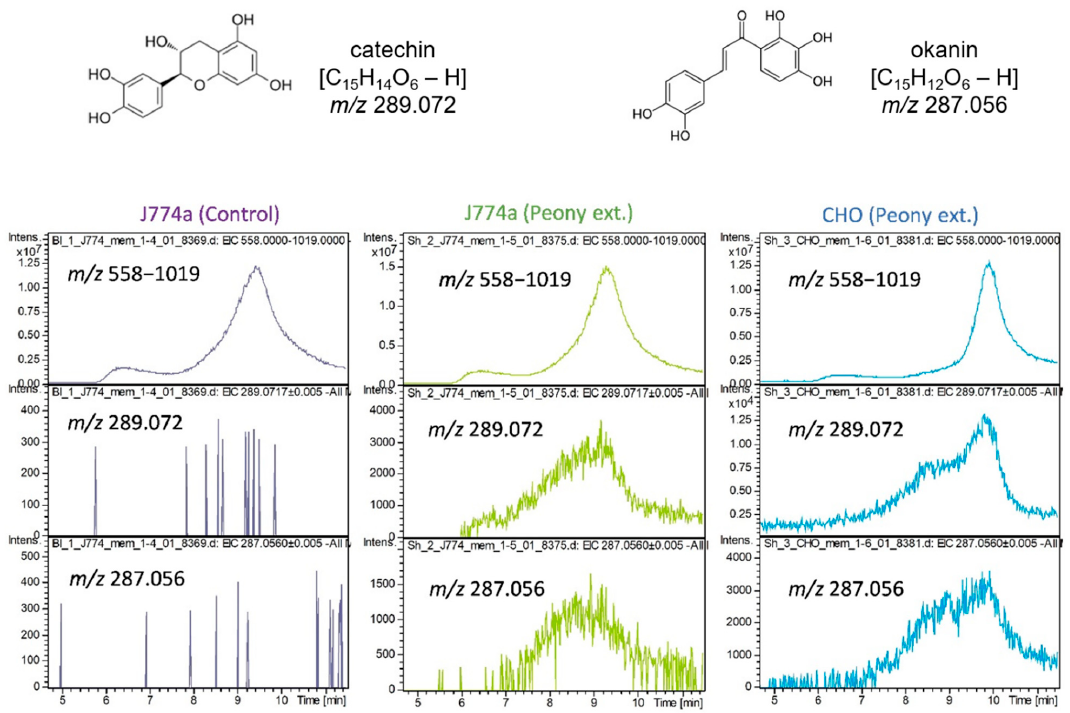
Figure 3. Detection of interactions between membrane proteins and peony extracts. Membrane proteins were extracted from J774a, or CHO cells cultured in a 100 mm dish. The peony or control extract was added to the membrane protein fractions, and the mixture was injected into the SEC-MS. Interactions were analyzed for the top 50 m/z signals detected in the ingredient analysis of the extract using the APCI ‐ negative detection mode. The results showed interactions between the peony extract catechin ( m/z 289.072) or okanin ( m/z 287.056, presumably assigned) and the proteins ex ‐ tracted from the cells.